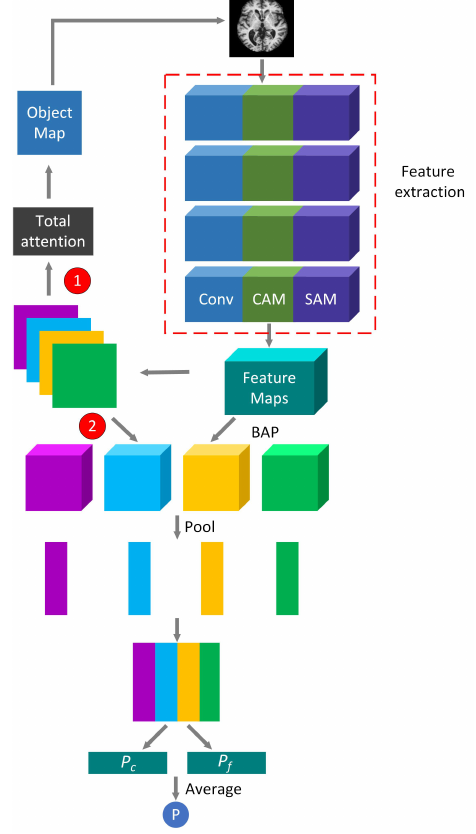
Figure 5. The test process of WS-AMN.